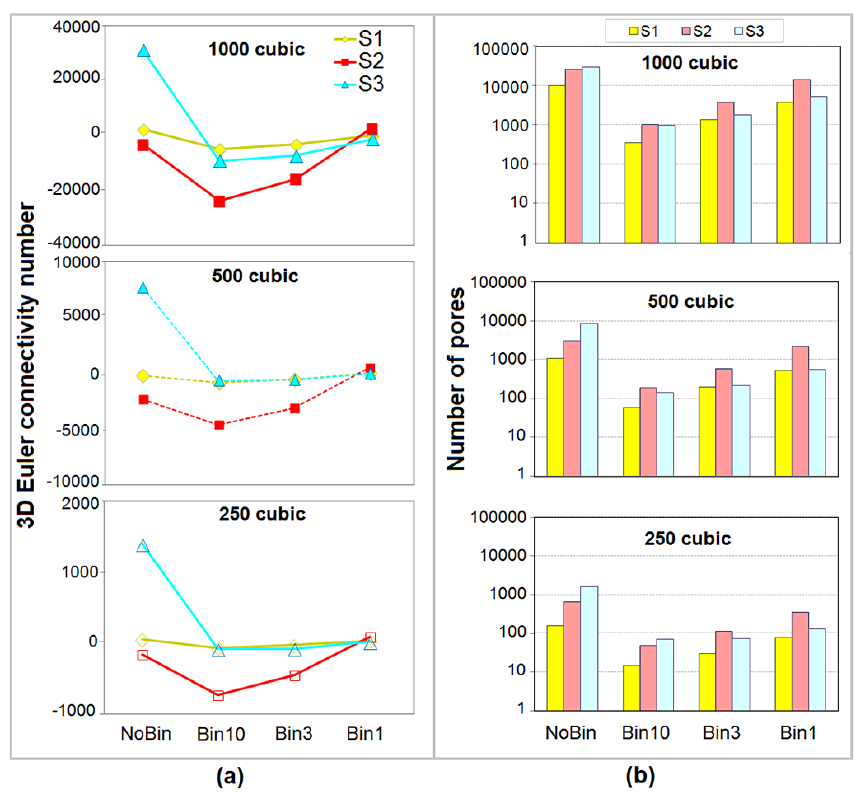
Figure 5. Quantification of the pore network fragmentation by using the Euler number (a) and number of segmented pores (b) during the binning operations for the three rocks and three different domain sizes,